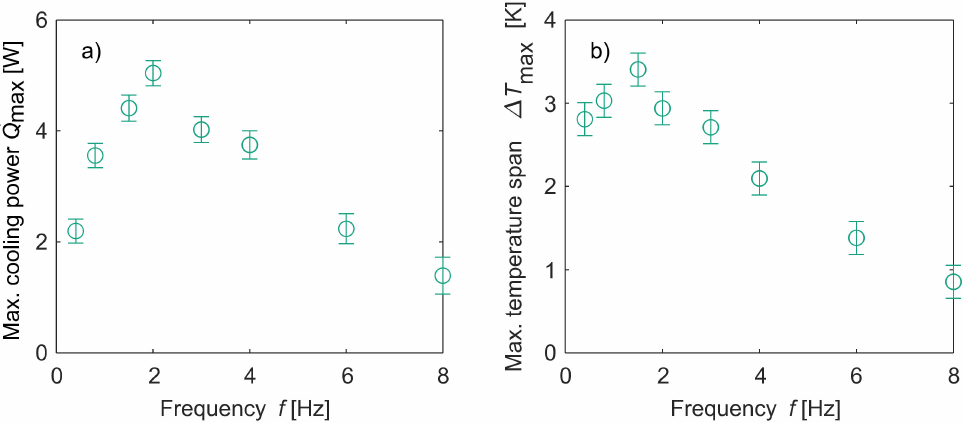
Figure 6. ( a ) shows the maximum cooling power of the AEH for different frequencies. ( b ) The maximum temperature span of the AEH for different